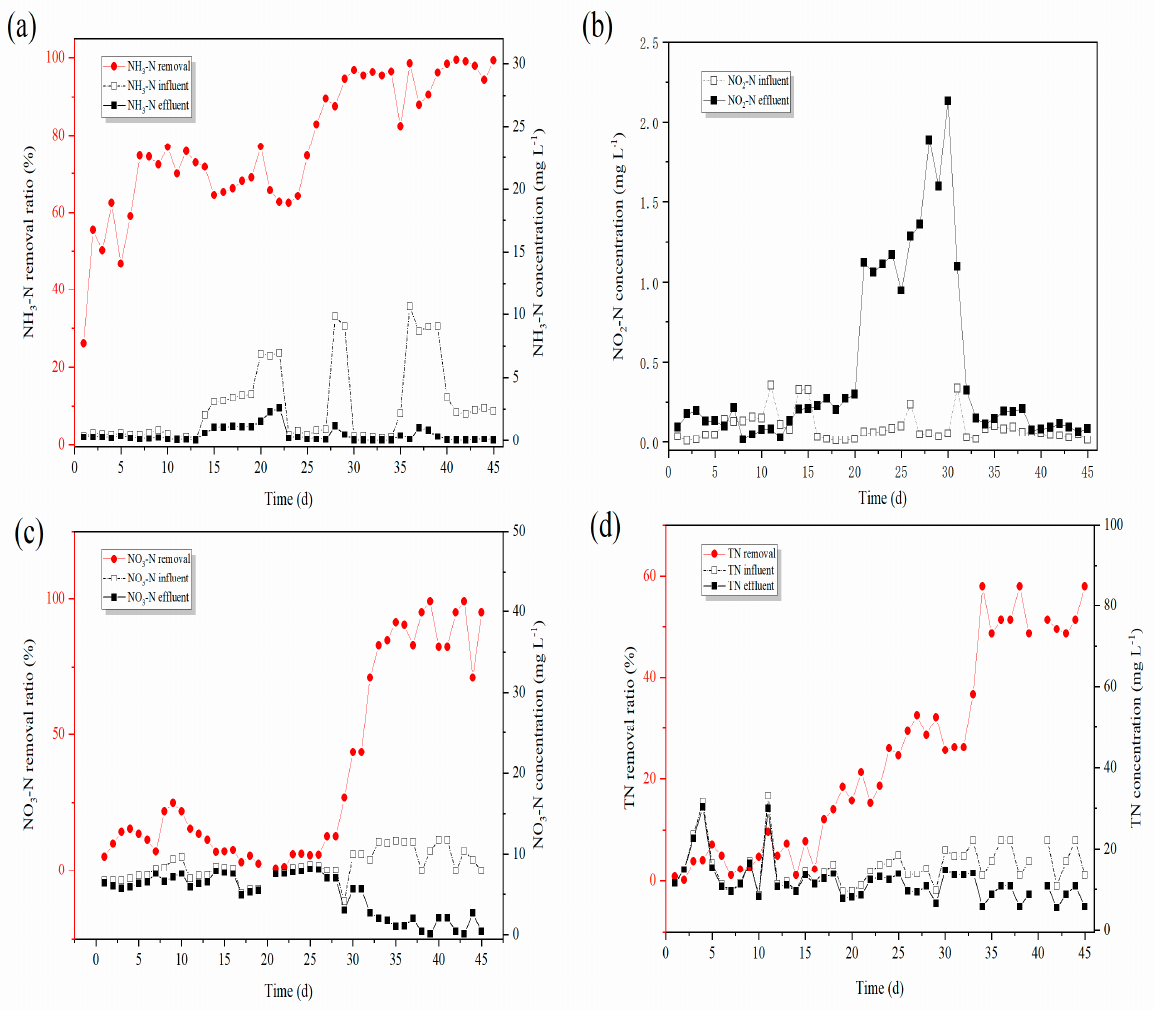
Figure 1. Denitrification efficiency of the MBR based on the NH 3 − N( a ), NO 2 − N( b ), NO 3 − N( c ), and TN( d )concentrations.